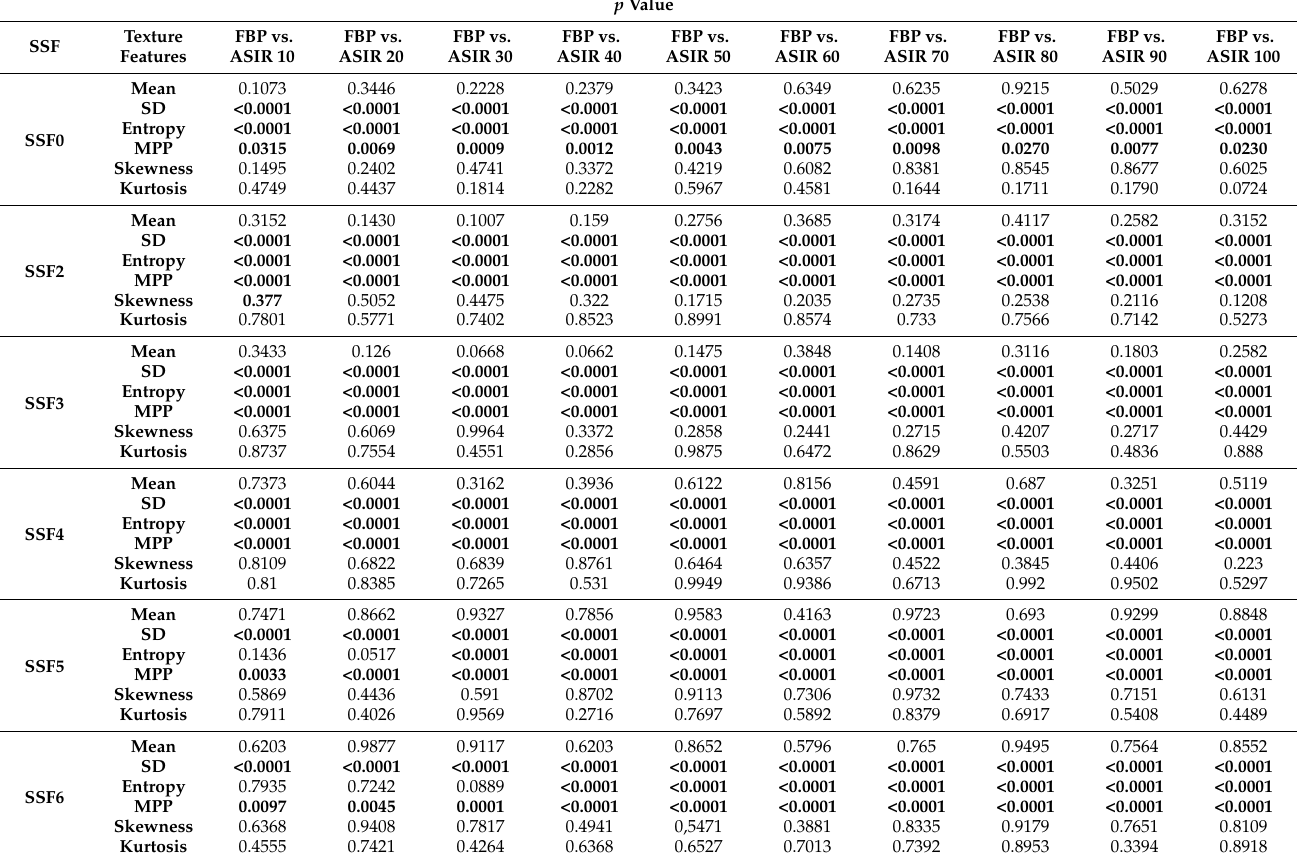
Table 2. CTTA (CT texture analysis) of the liver on SSF0, SSF2, SSF3, SSF4, SSF5 and SSF6 filtered images; each feature (standard deviation (SD), mean, entropy, mean of positive pixels (MPP), skewness and kurtosis) is compared between filtered back projection (FBP) and all Adaptive Statistical Iterative Reconstruction-V (ASIR-V) reconstructions. Significant p in bold. p